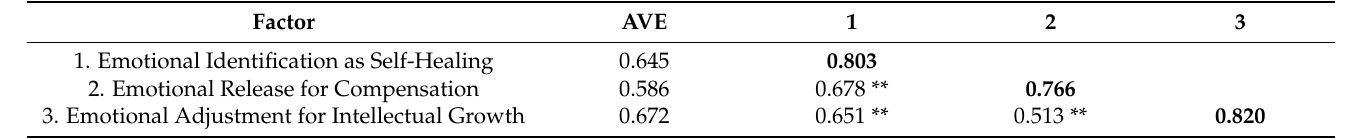
√ Table 5. AVE, AVE, and correlation coefficients ( r ) between